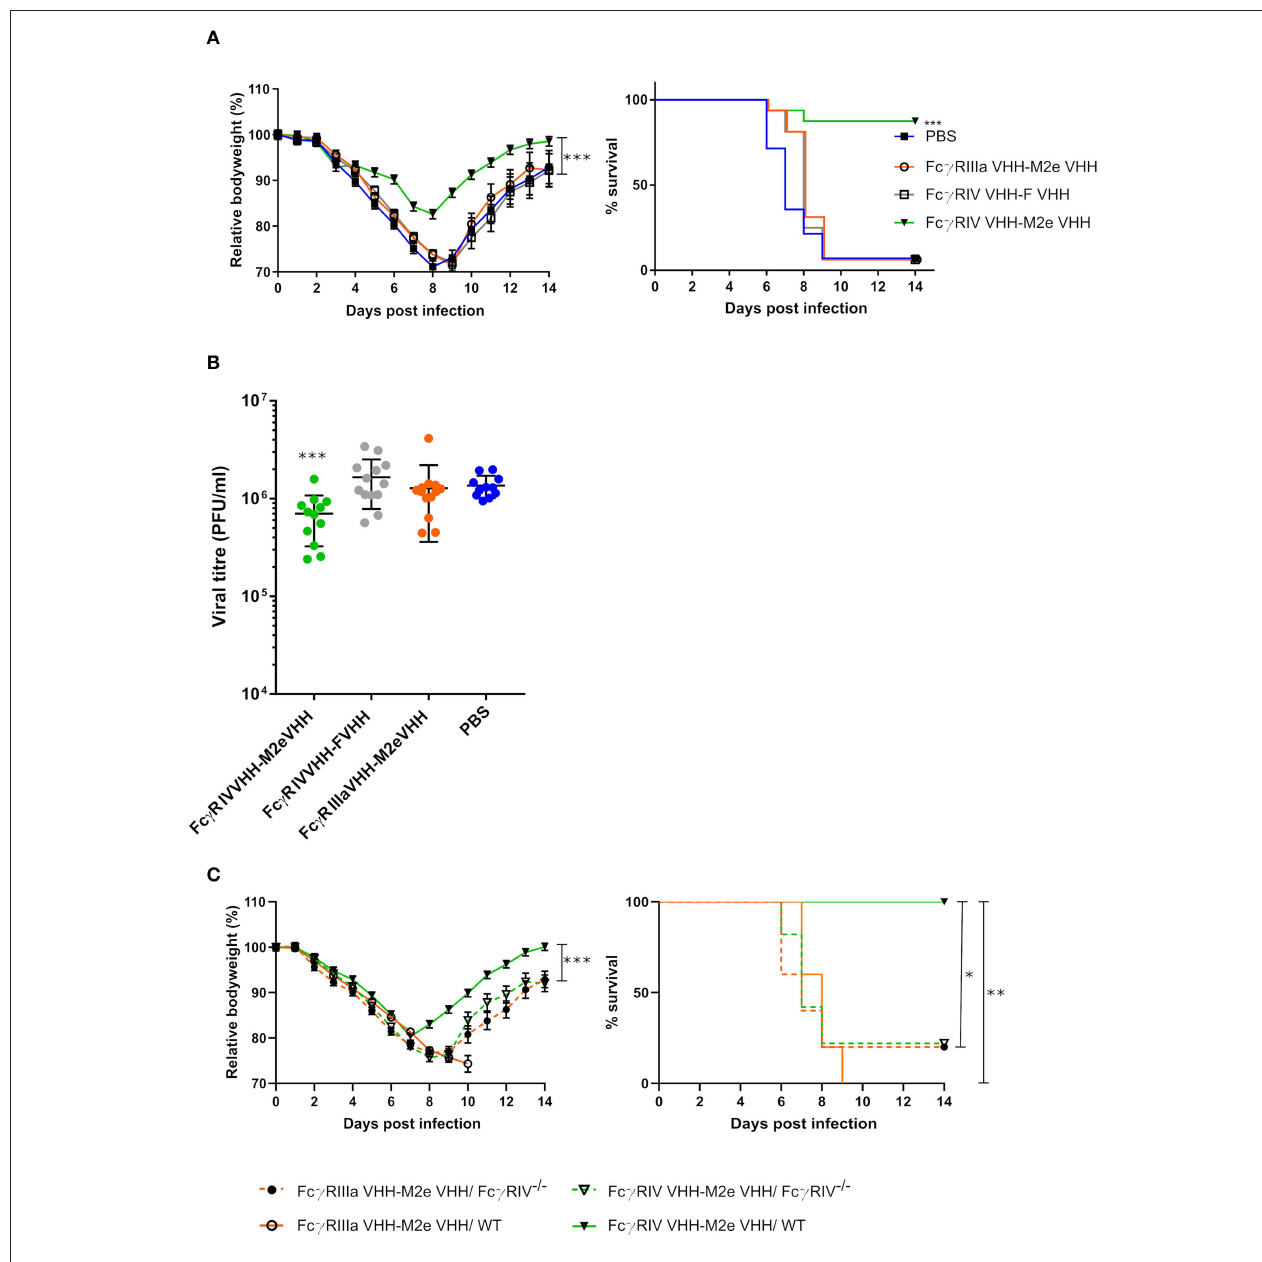
FIGURE 7 | Bispecific fusion construct of a Fc γ RIV- and M2e-specific VHH protects mice against a potentially lethal influenza A virus infection. (A) Groups of 16 (bispecific VHHs) or 14 (PBS) BALB/c mice were intranasally treated with 50 µ g of the bispecific VHHs or PBS 4h before and 24h after challenge with 2xLD 50 of A/X47 (H3N2) influenza virus. Body weight change (left) and survival (right) were monitored for 14 days. The mean relative changes in body weight together with their standard errors, are represented. The difference in body weight loss between Fc γ RIV VHH-M2e VHH and the negative-control groups was statistically significant (*** P < 0.001, REML variance components analysis). The survival rate of the group receiving Fc γ RIV VHH-M2e VHH was significantly different from Fc γ RIV VHH-F VHH control treatment group (*** p < 0.001, Log-rank test). (B) To determine the effect on the viral load in the lungs, groups of 13 (bispecific VHHs) or 11 (PBS) BALB/c mice received 50 µ g of the bispecific VHHs or PBS 4h before and 24h after viral challenge with 2xLD 50 of A/X47 (H3N2) influenza virus. On day 6 after infection, the lungs were harvested and the viral titer was determined by plaque assay. The viral titer of mice Fc γ RIV VHH-M2e VHH was significantly different compared to mice that received the Fc γ RIV VHH-F VHH control treatment (*** P < 0.001, unpaired t -test). (C) Groups of 5 wild-type and Fc γ RIV − / − C57BL/6 mice (male and female mice) were treated with 50 µ g of the bispecific VHHs 4h before and 24h after viral challenge with 2xLD 50 of A/X47 (H3N2) influenza virus and body weight (left) and survival (right) were monitored. In the left-hand graph, data points represent means and error bars represent the standard errors of the means. Body weight changes between Fc γ RIV VHH-M2e VHH treated wild-type and Fc γ RIV − / − mice were significantly different (*** P < 0.001, REML variance components analysis). The survival rate of wild-type mice that received Fc γ RIV VHH-M2e VHH was significantly different from wild-type mice treated with Fc γ RIIIa VHH-M2e VHH (** P < 0.01, REML variance components analysis) and Fc γ RIV − / − mice treated with Fc γ RIV VHH-M2e VHH and Fc γ RIIIa VHH-M2e VHH (* P < 0.05, REML variance components analysis). Data in (A,B) are pooled from 2 independent